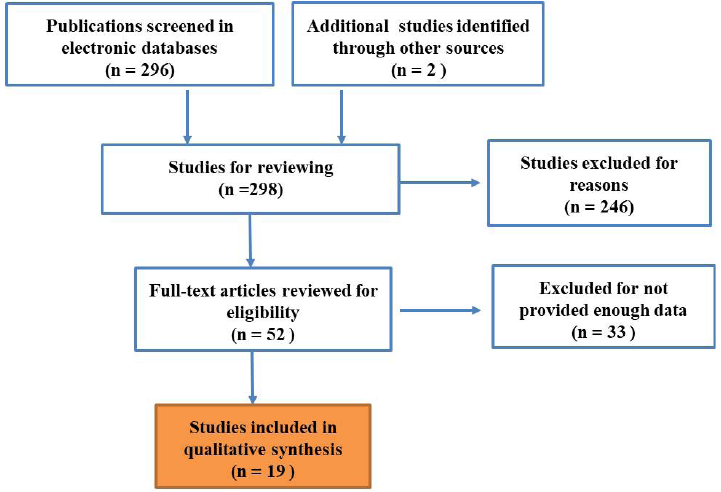
Figure 1: Flow chart of the studies screening in the databases.